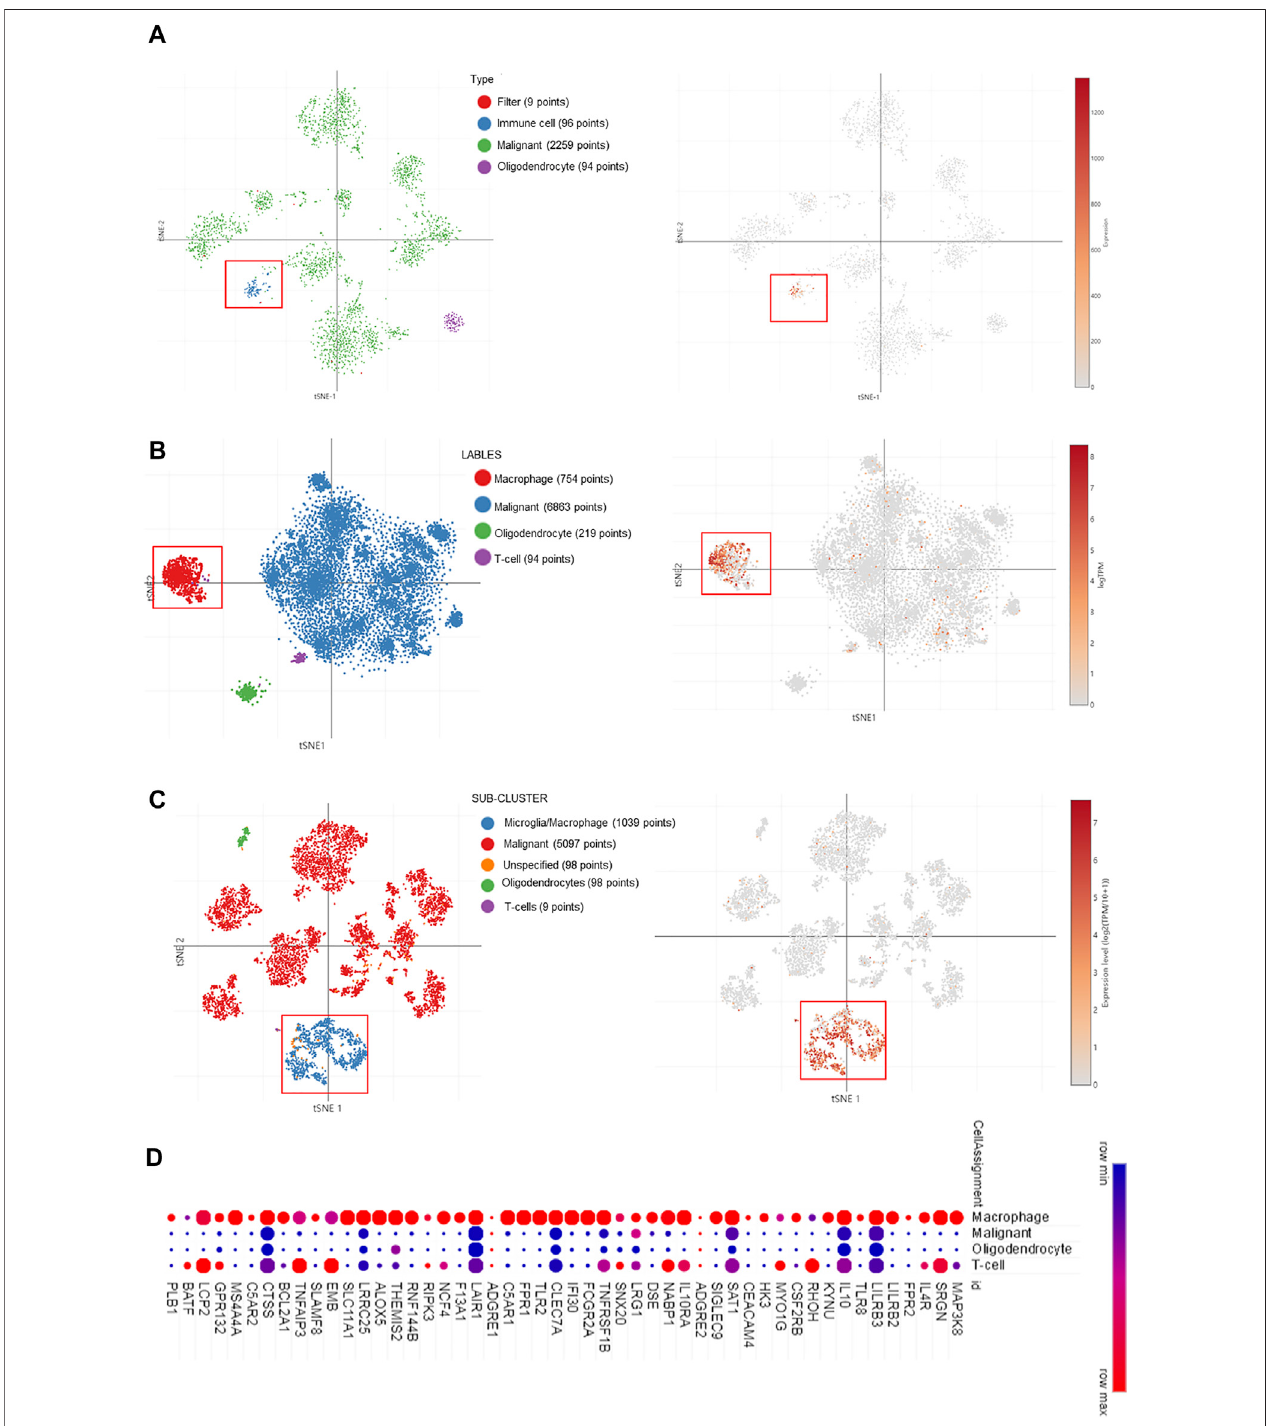
FIGURE 5 | MAP3K8 expression in glioma from single-cell RNA sequencing data. (A – C) MAP3K8 expression in different sub-clusters of glioma from study 1 (A) , study 2 (B) , and study 3 (C) . (D) The top 25 genes positively associated with MAP3K8 mainly enriched in different sub-clusters of glioma.